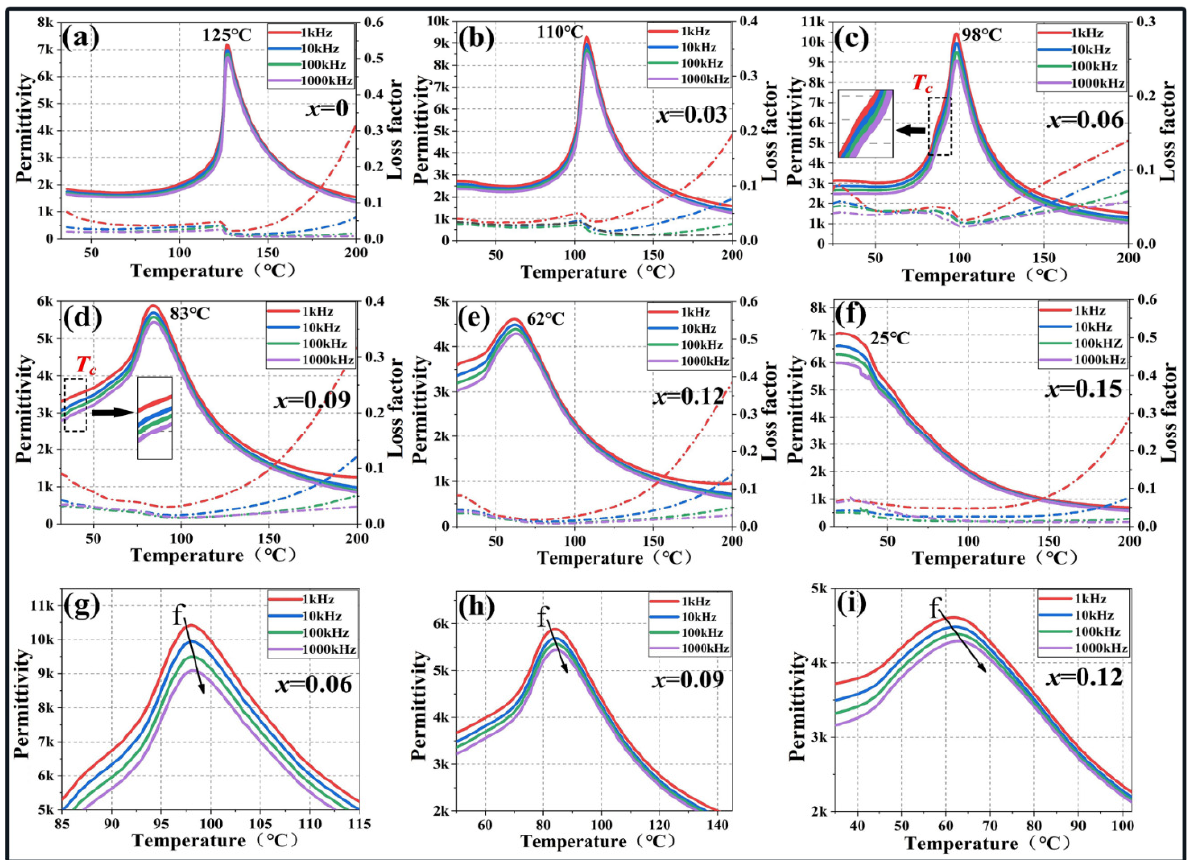
Figure 5. ( a – f ) Permittivity and loss factor of the (1 − x )BT- x CSZ (0 ≤ x ≤ 0.15) ceramics measured at various frequencies. ( g – i ) Enlarged view of the dielectric peaks for the (1 − x )BT- x CSZ ceramics with x = 0.06, 0.09 and 0.12.